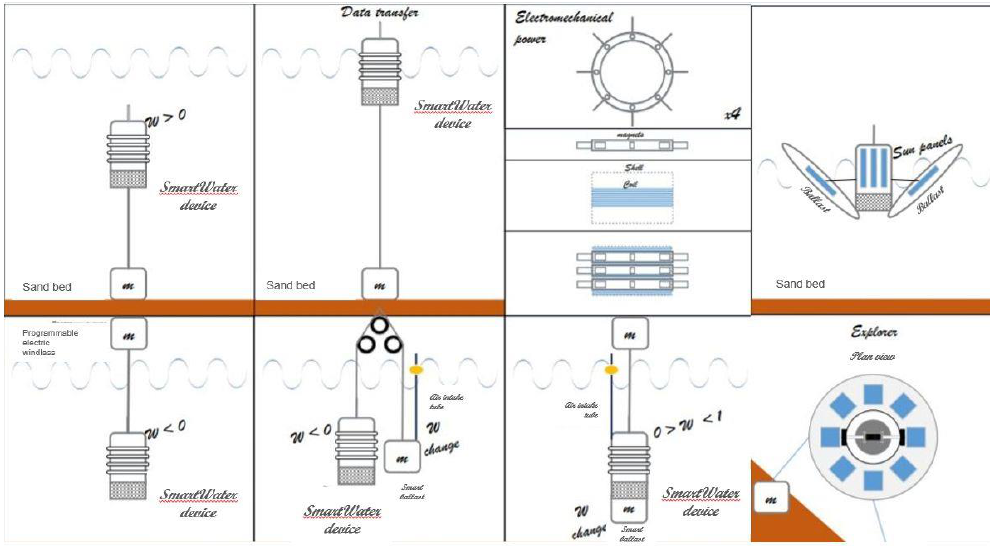
Figure 3. Examples of the device placement by